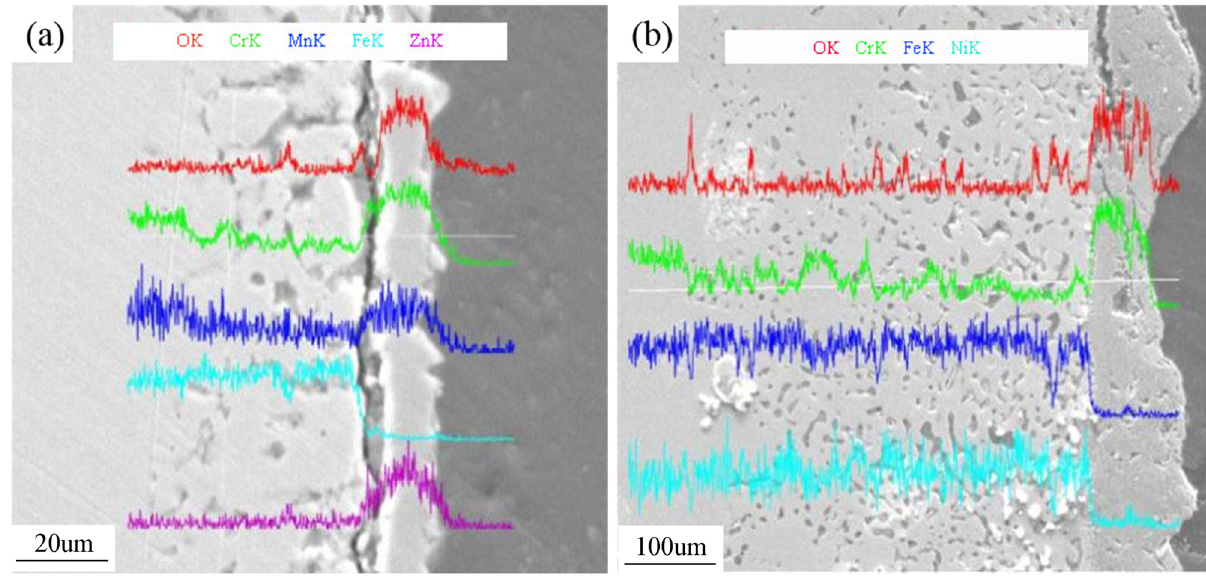
Figure 3: Cross - sectional morphologies of 316 ss after corrosion in ternary chloride molten salt at 700°C ( a ) 900°C ( b ) for 60 h together with element distributions along the white